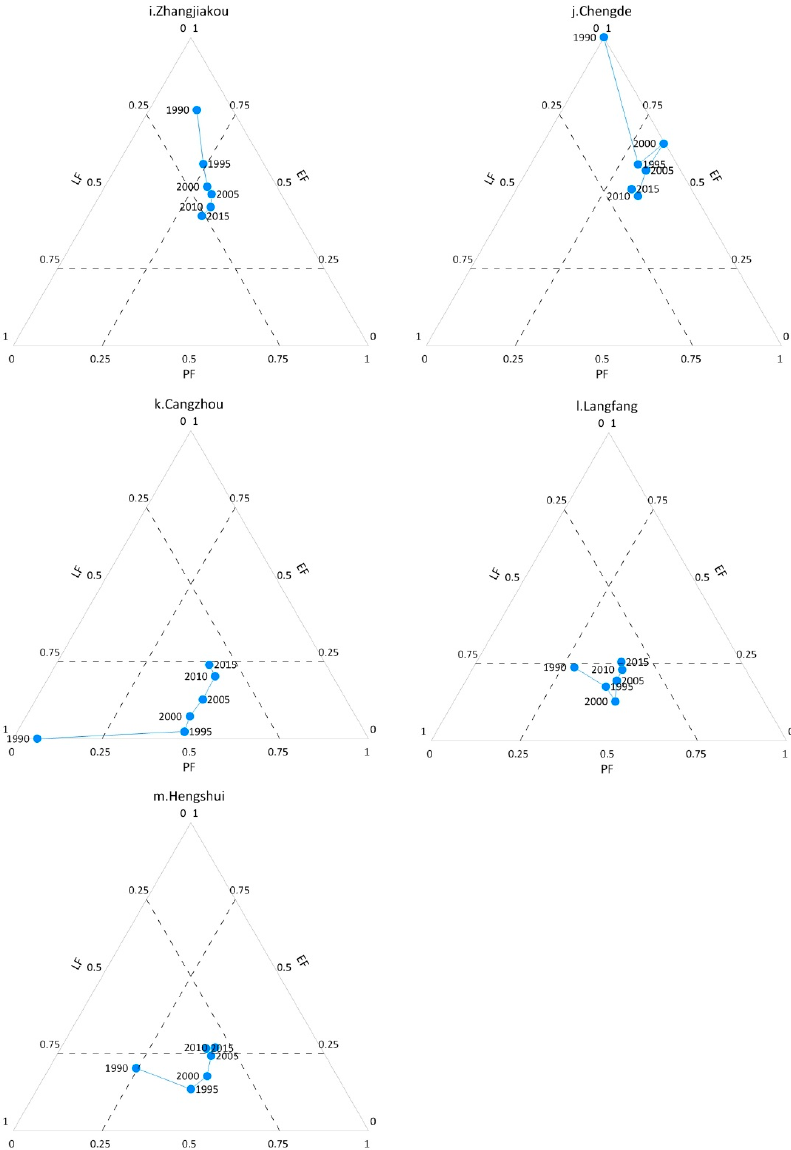
Figure 7. The stage and trend of the production-living-ecology land use multifunctionality in the thirteen cities in the Beijing-Tianjin-Hebei region (1990–2015). ( a) Beijing; ( b) Tianjin; ( c) Shijiazhuang; ( d) Tangshan; ( e) Qinhuangdao; ( f) Handan; ( g) Xingtai; ( h) Baoding; ( i) Zhangjiakou; ( j) Chengde; ( k) Cangzhou; ( l) Langfang; ( m) Hengshui.